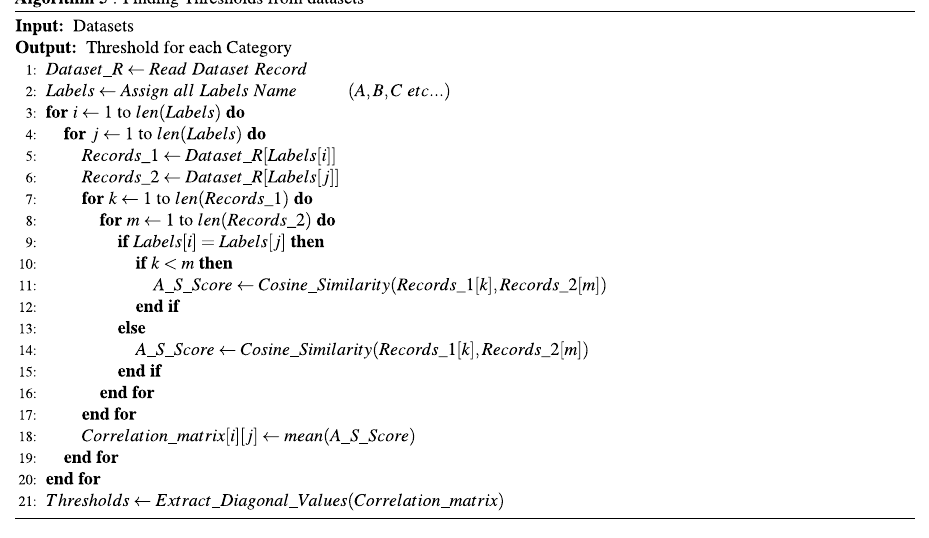
Figure 6. Finding threshold